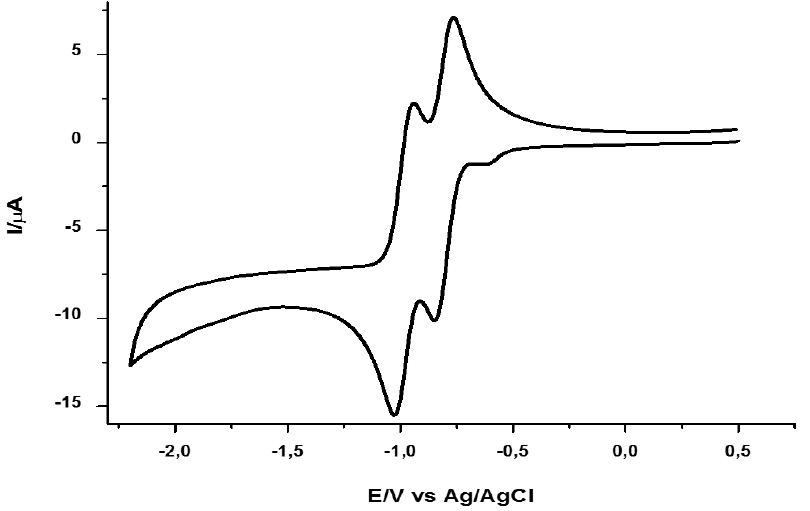
Figure 4. Cyclic voltammogram of pyridinium salt 3a (1 mM) in DMF, with 0.1 M TBPA as a supporting electrolyte and a scan rate of 100 mV/s.